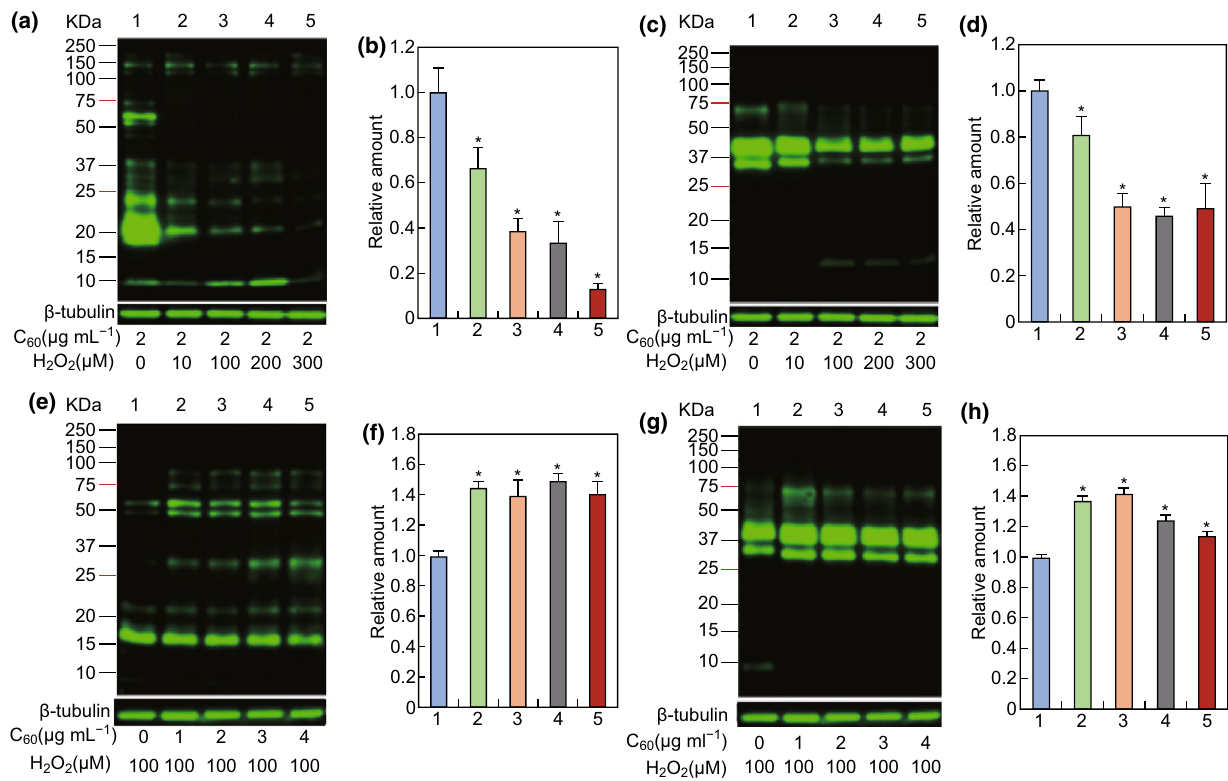
Fig. 6 C 60 -induced P-PKAs and PTP were affected by a series of H 2 O 2 concentrations. a , b Western blot analysis was performed using an anti- phospho-PKA substrate antibody. c , d Western blot analysis was performed using an anti-phosphotyrosine antibody. Spermatozoa were incu- bated in basal medium containing 2 μg mL −1 carboxylated C 60 and a series of H 2 O 2 concentrations (0, 10, 100, 200, and 300 μM). β-Tubulin was used as an internal control. e , f Western blot analysis was performed using anti-phospho-PKA substrate antibody. g , h Western blot analysis was performed using anti-phosphotyrosine antibody. The experiment was performed at least three times, and the image presented is representative and repeatable. (n = 3, * P <